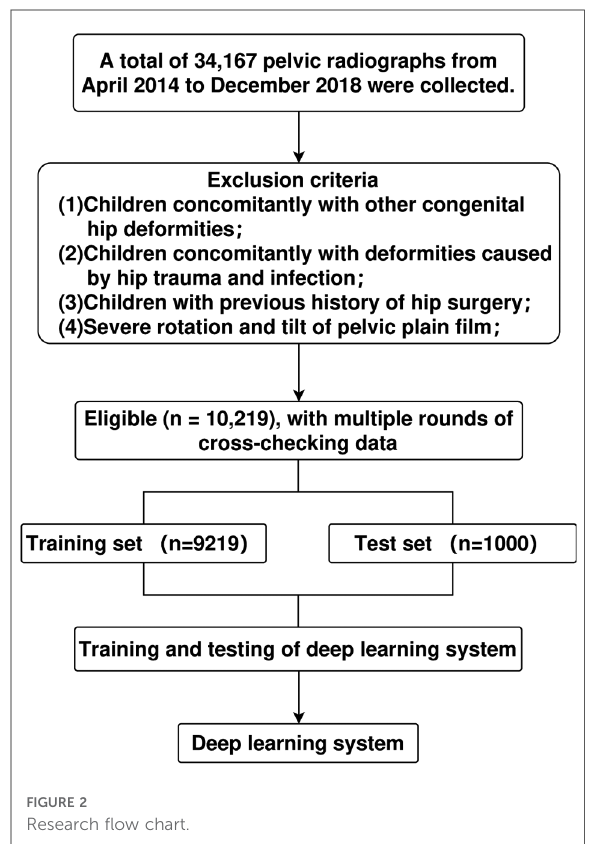
FIGURE 2 Research fl ow